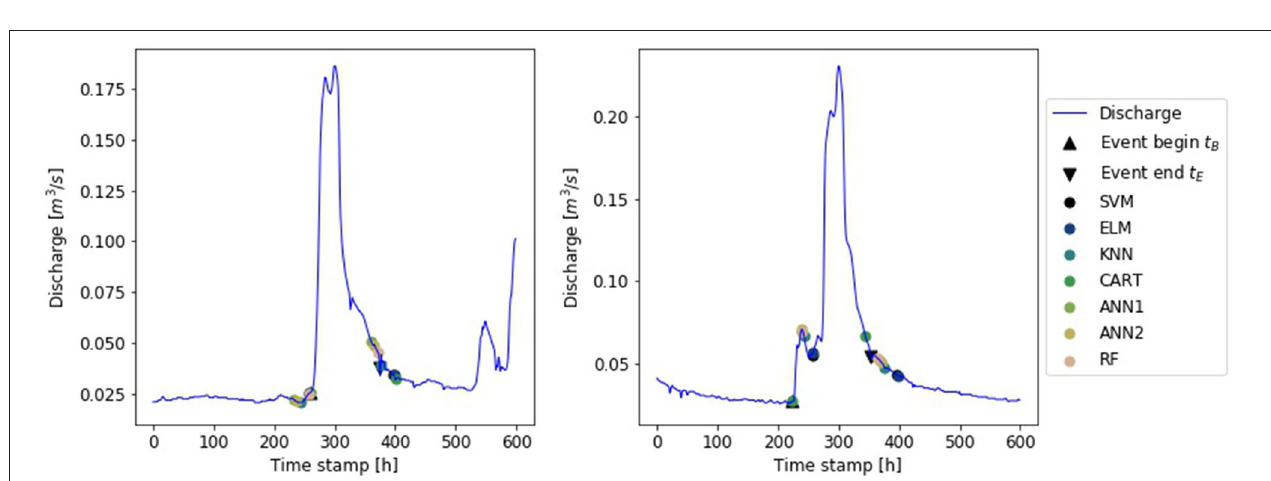
FIGURE 4 | Dependence of the number of hydrograph ordinates and the mean volume reproduction (MVR) and temporal coverage (COV) of automatically separated flood events. Application of a trained RF in sub-basin Bad-Berneck.